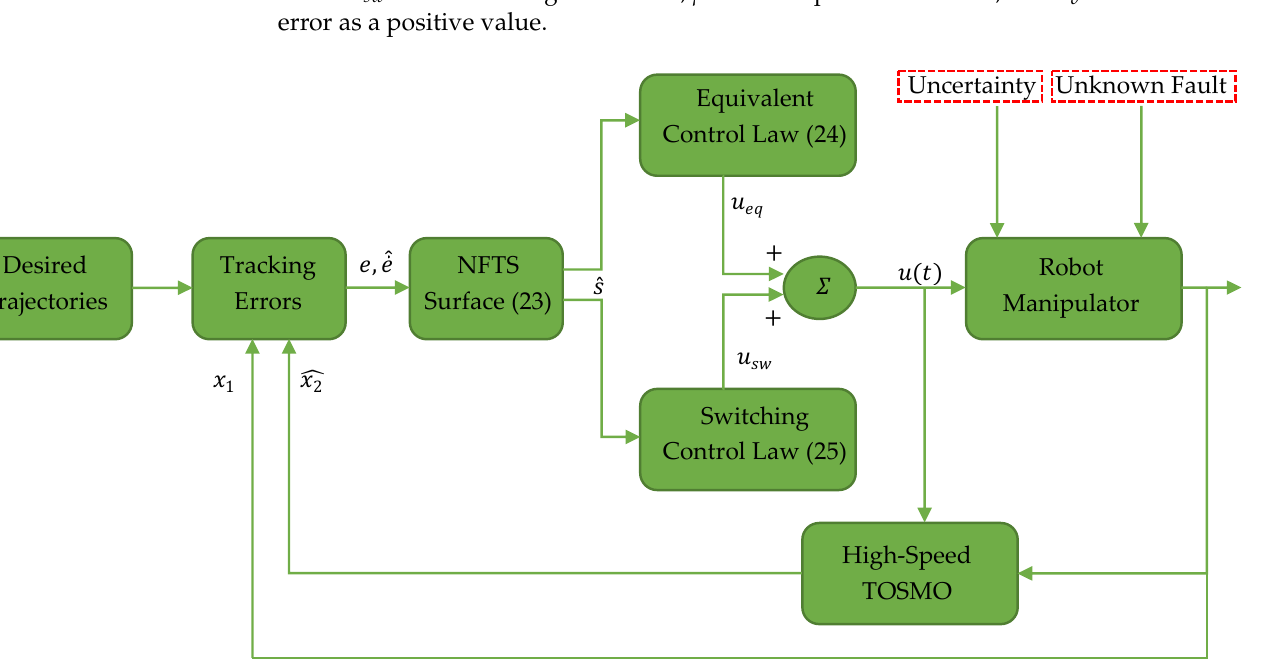
Figure 8. Structure of the NFTSMC-TOSMO control method [49].